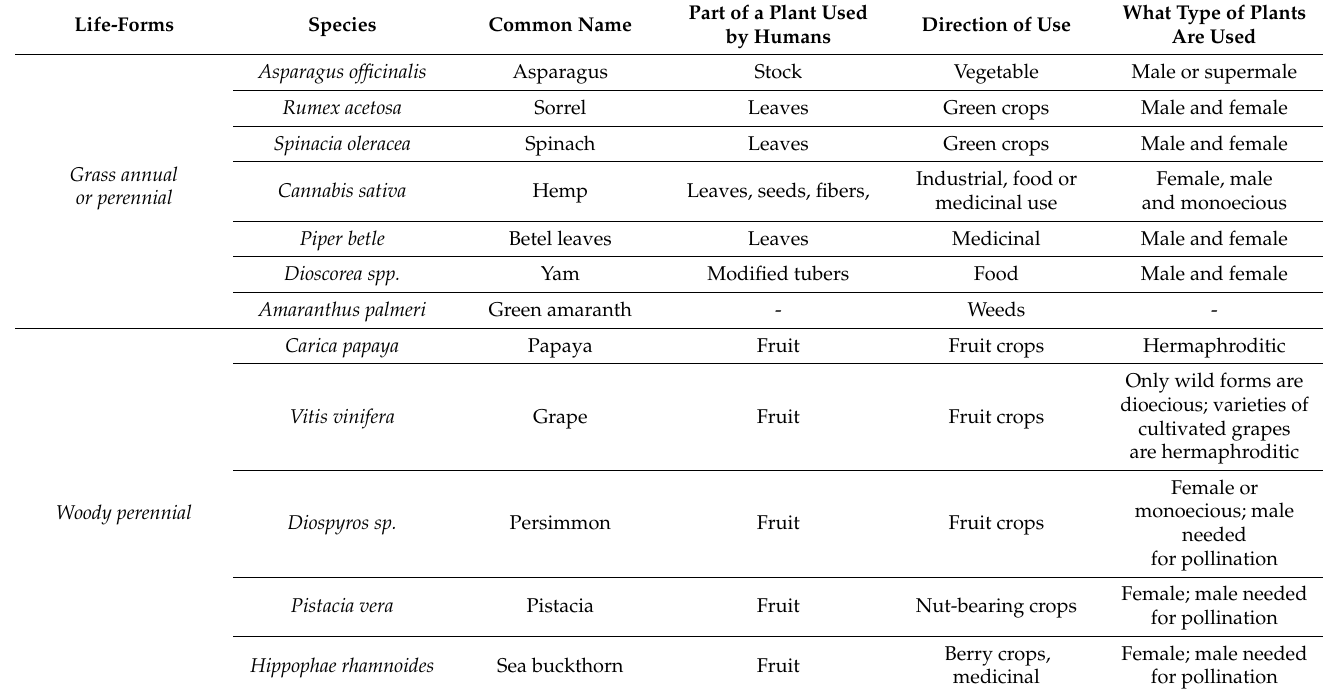
Table 2. Particular qualities of the most agriculturally important dioecious plants